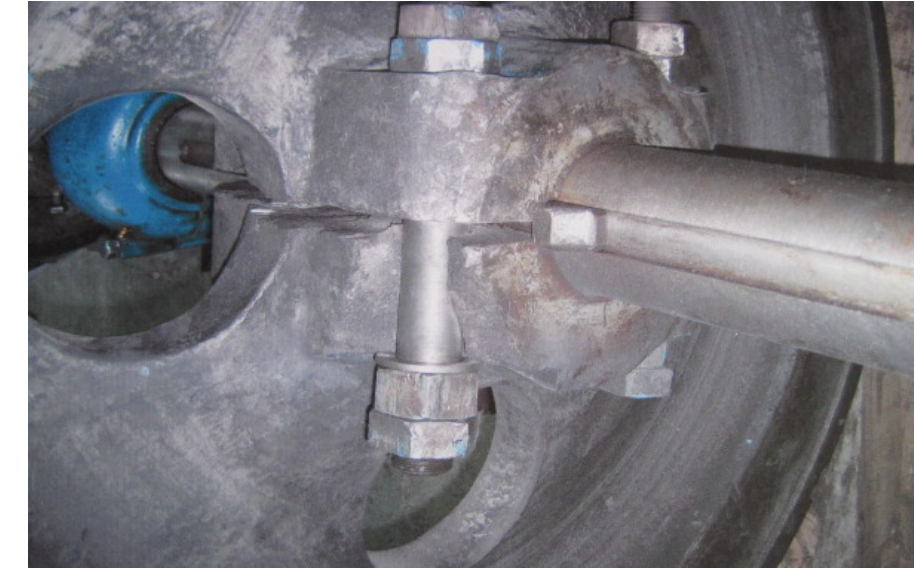
Figure 4 – Damaged flywheel of a mini hydro power plant Рис . 4 – Изображение повреждений маховика мини - ГЭС Слика 4 – Приказ оштећења замајца мини -